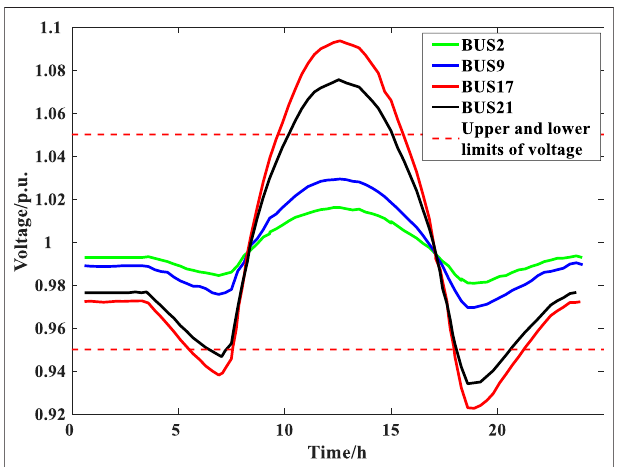
fi les of the four PV access nodes on a